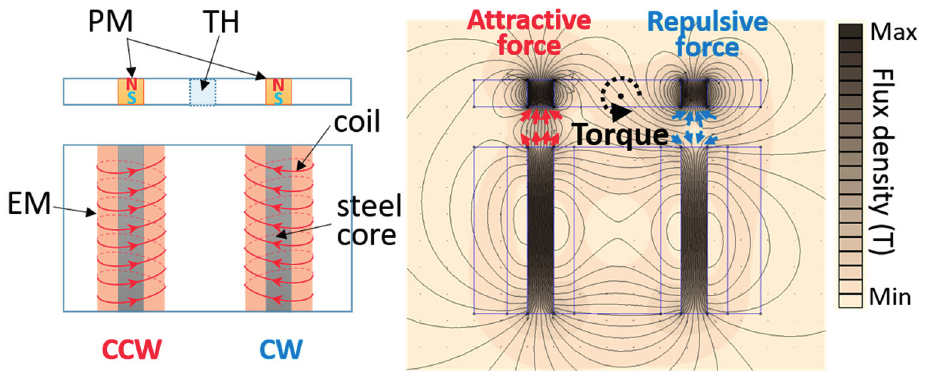
Figure 2. Simulated magnetic field distribution induced by electromagnets within the 2A-PDMS-WP-scanner. PM, permanent magnets; EM, electromagnets; TH,